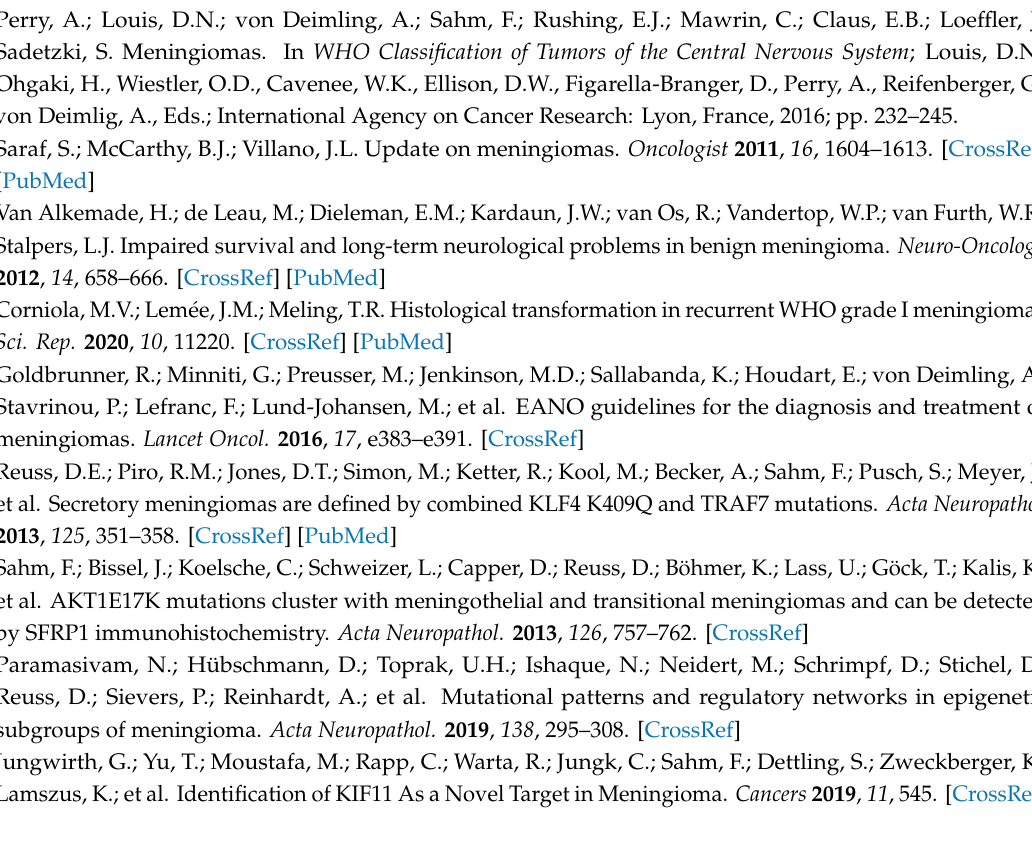
Figure S1. Quantification of blood vessels using EvG (mean 53.8 ± 39.5 vessels / 4 HPF) and CD34 staining (mean 52.8 ± 39.8 vessels / 4 HPF). Figure S2. Representative images of blood vessels (arrow) without VEGF (A), IGFBP-3 (B), and PlGF (C) expression (original magnification 200 × ). Table S1. Clinical and histopathological variables of patients undergoing proteome analysis. n = number, men. = meningothelial, tran. = transitional, f = female, m = male, PFS = progressionfree survival, OS = overall survival, HPF = high